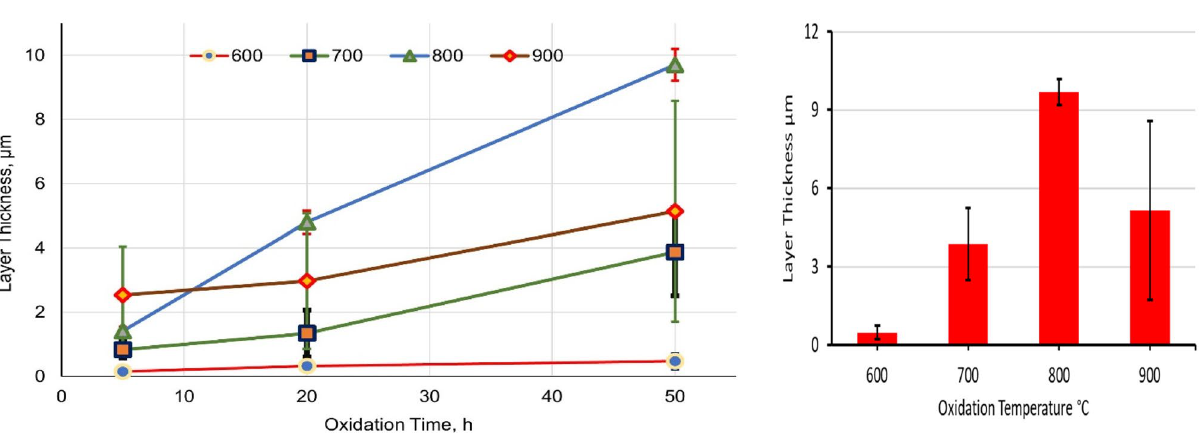
Figure 9. Average thickness of oxide layers after oxidation at different temperatures and